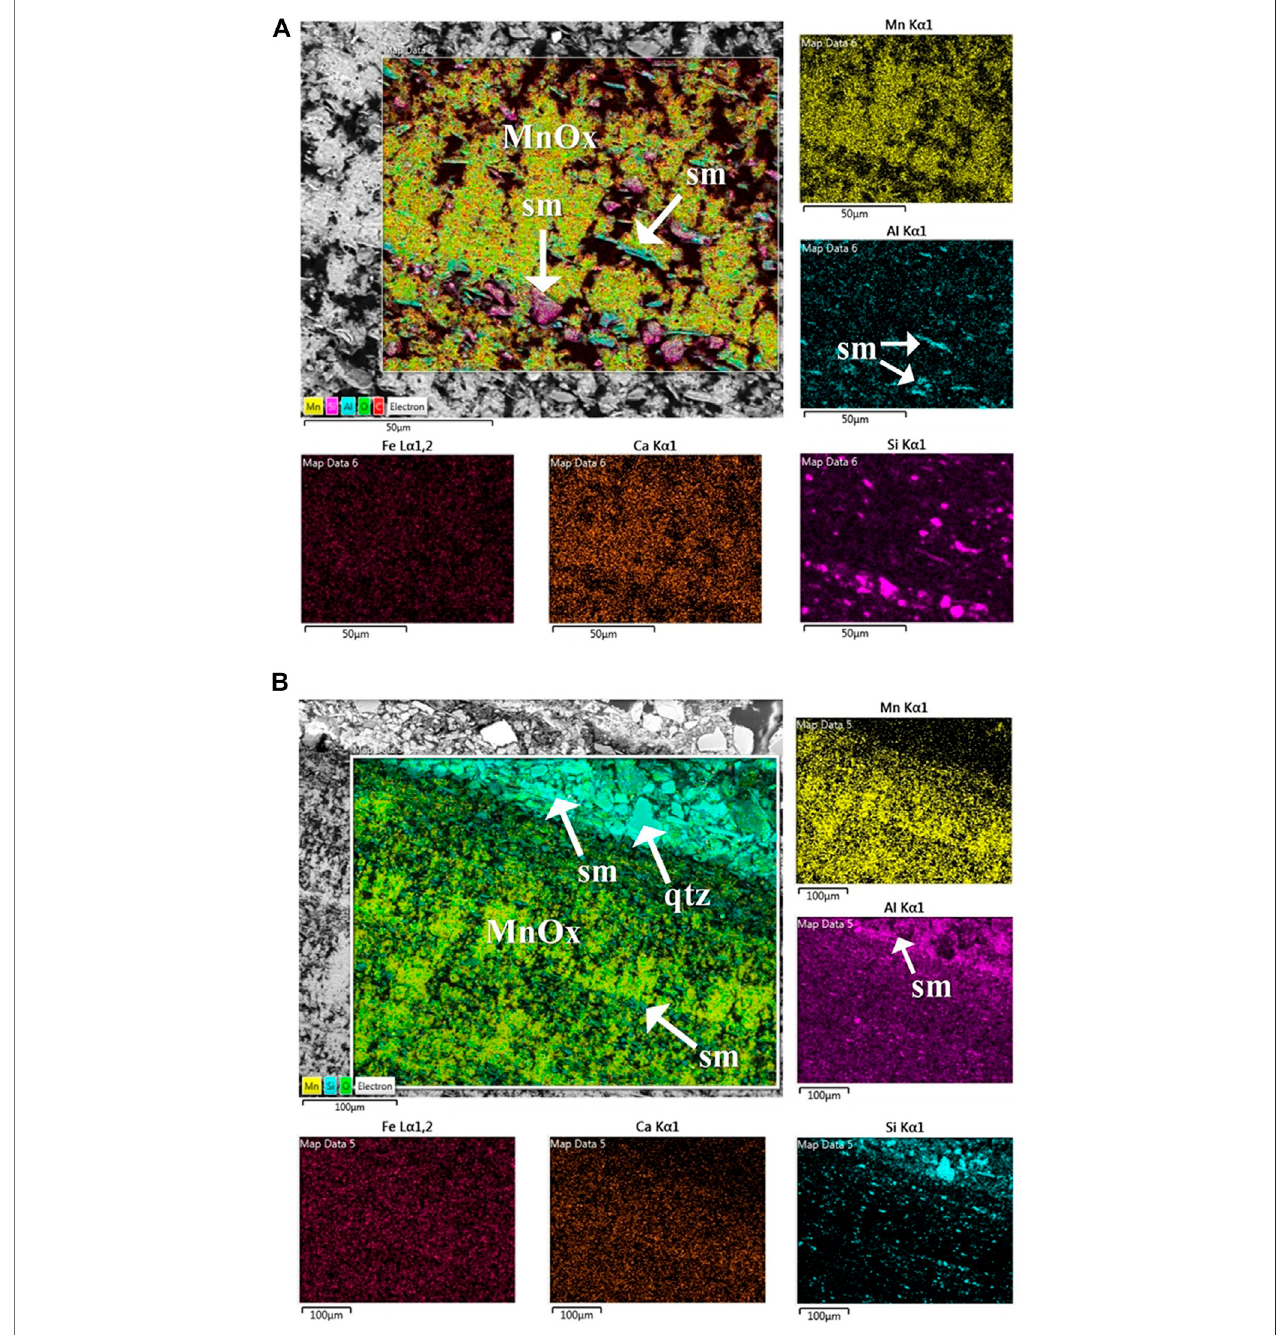
FIGURE2| Energy dispersive spectroscopy(EDS)elementalmappingimages ofalayerdeposited ontherock wall,showingthedistribution ofchemicalelements. (A) The area of the map is occupied essentially of Ca-bearing Mn oxides (MnOx on the combined map, Mn and Ca maps) intermixed with Fe-oxides and minor silicoclastic minerals (sm in the combined map and in Al map). (B) The combined map shows the layered structure of the sample where layers of quite pure Ca-bearing Mnoxides(MnOxonthecombinedmap,MnandCamaps)intermixedwithveryminorsiliciclasticminerals(sminthecombinedmapandinAlmap).Thegrainqtzin the combined map is a grain of quartz, which is the most abundant minerals in the silicoclastic component. Notably, Fe appears homogeneously distributed on all the mapped area (Fe map).